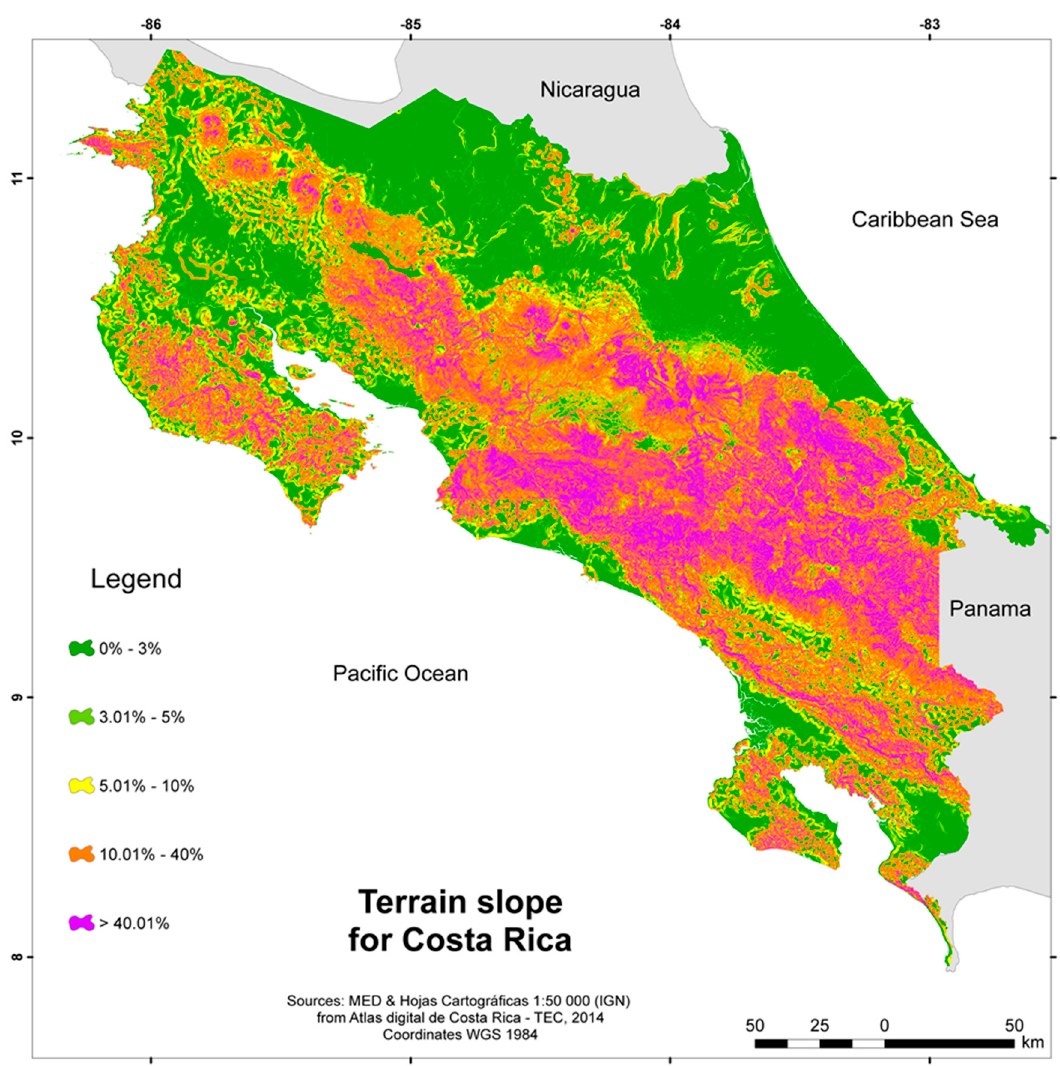
Figure 3. Terrain slope for Costa Rica based on the DEM by the TEC [44].